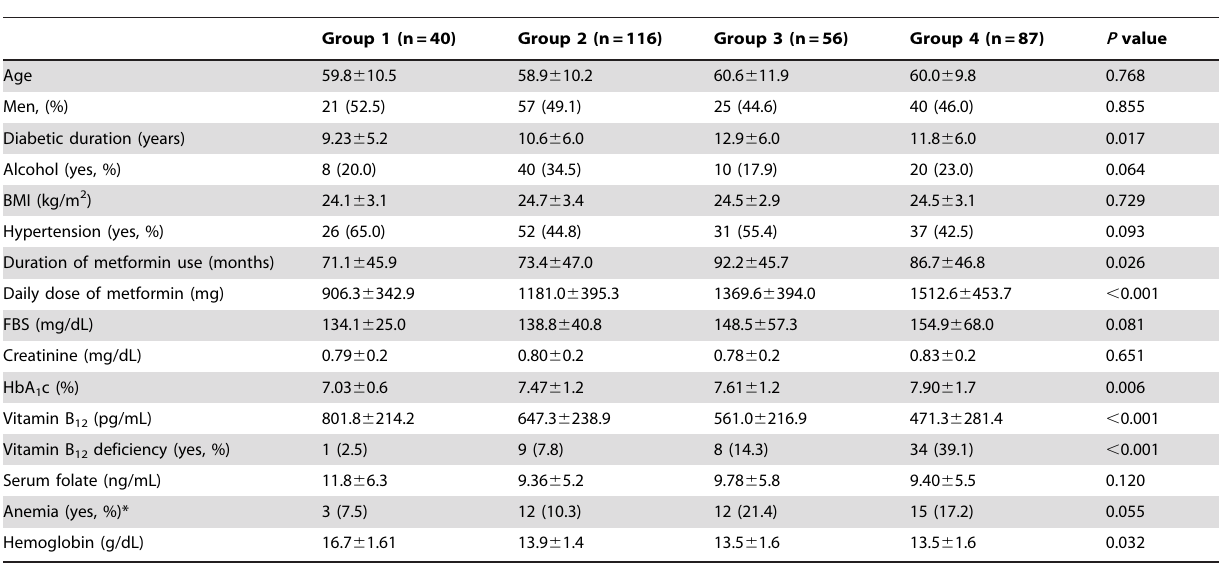
Table 5. Clinical characteristics according to daily dosage of